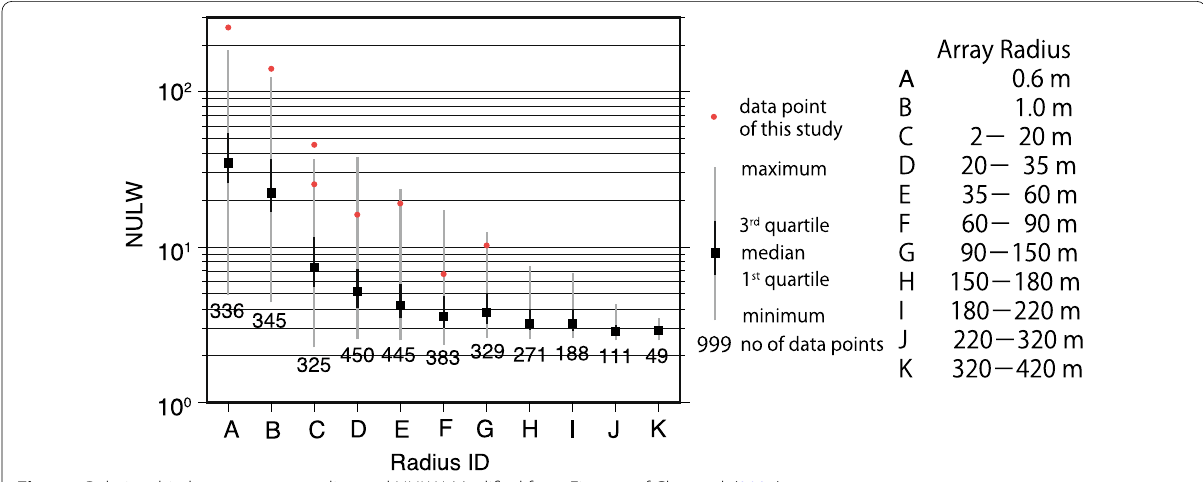
Fig. 11 Relationship between array radius and NULW. Modified from Fig. 11a of Cho et al.